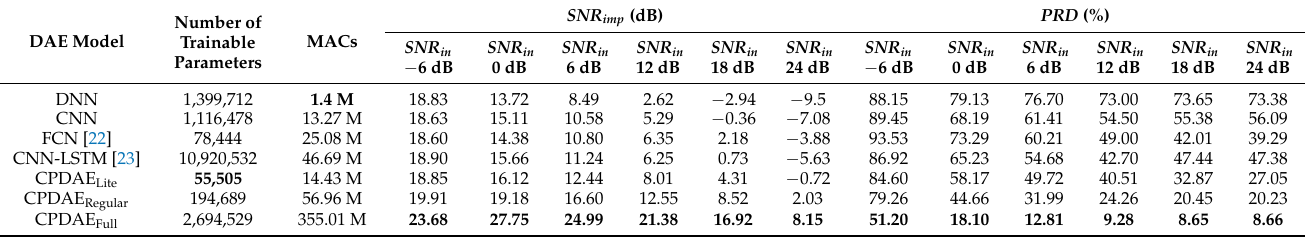
Table 6. Comparison of the Proposed Models with State-of-the-art Methods.